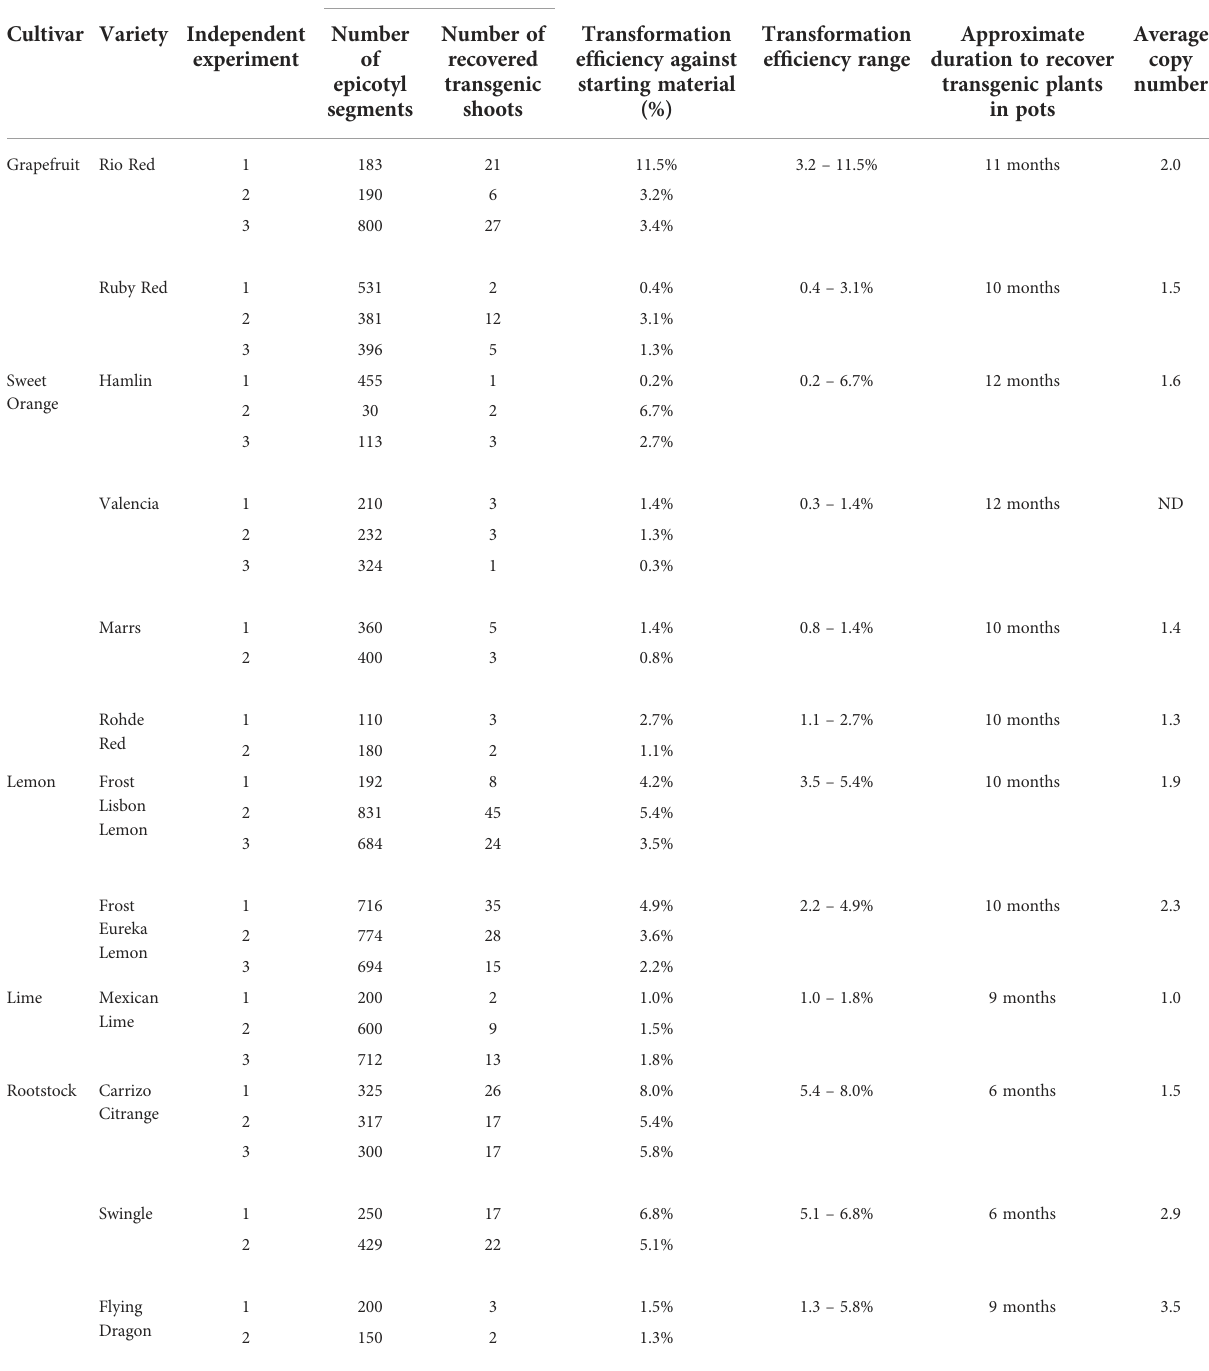
TABLE 3 Transformation ef fi ciency of different citrus